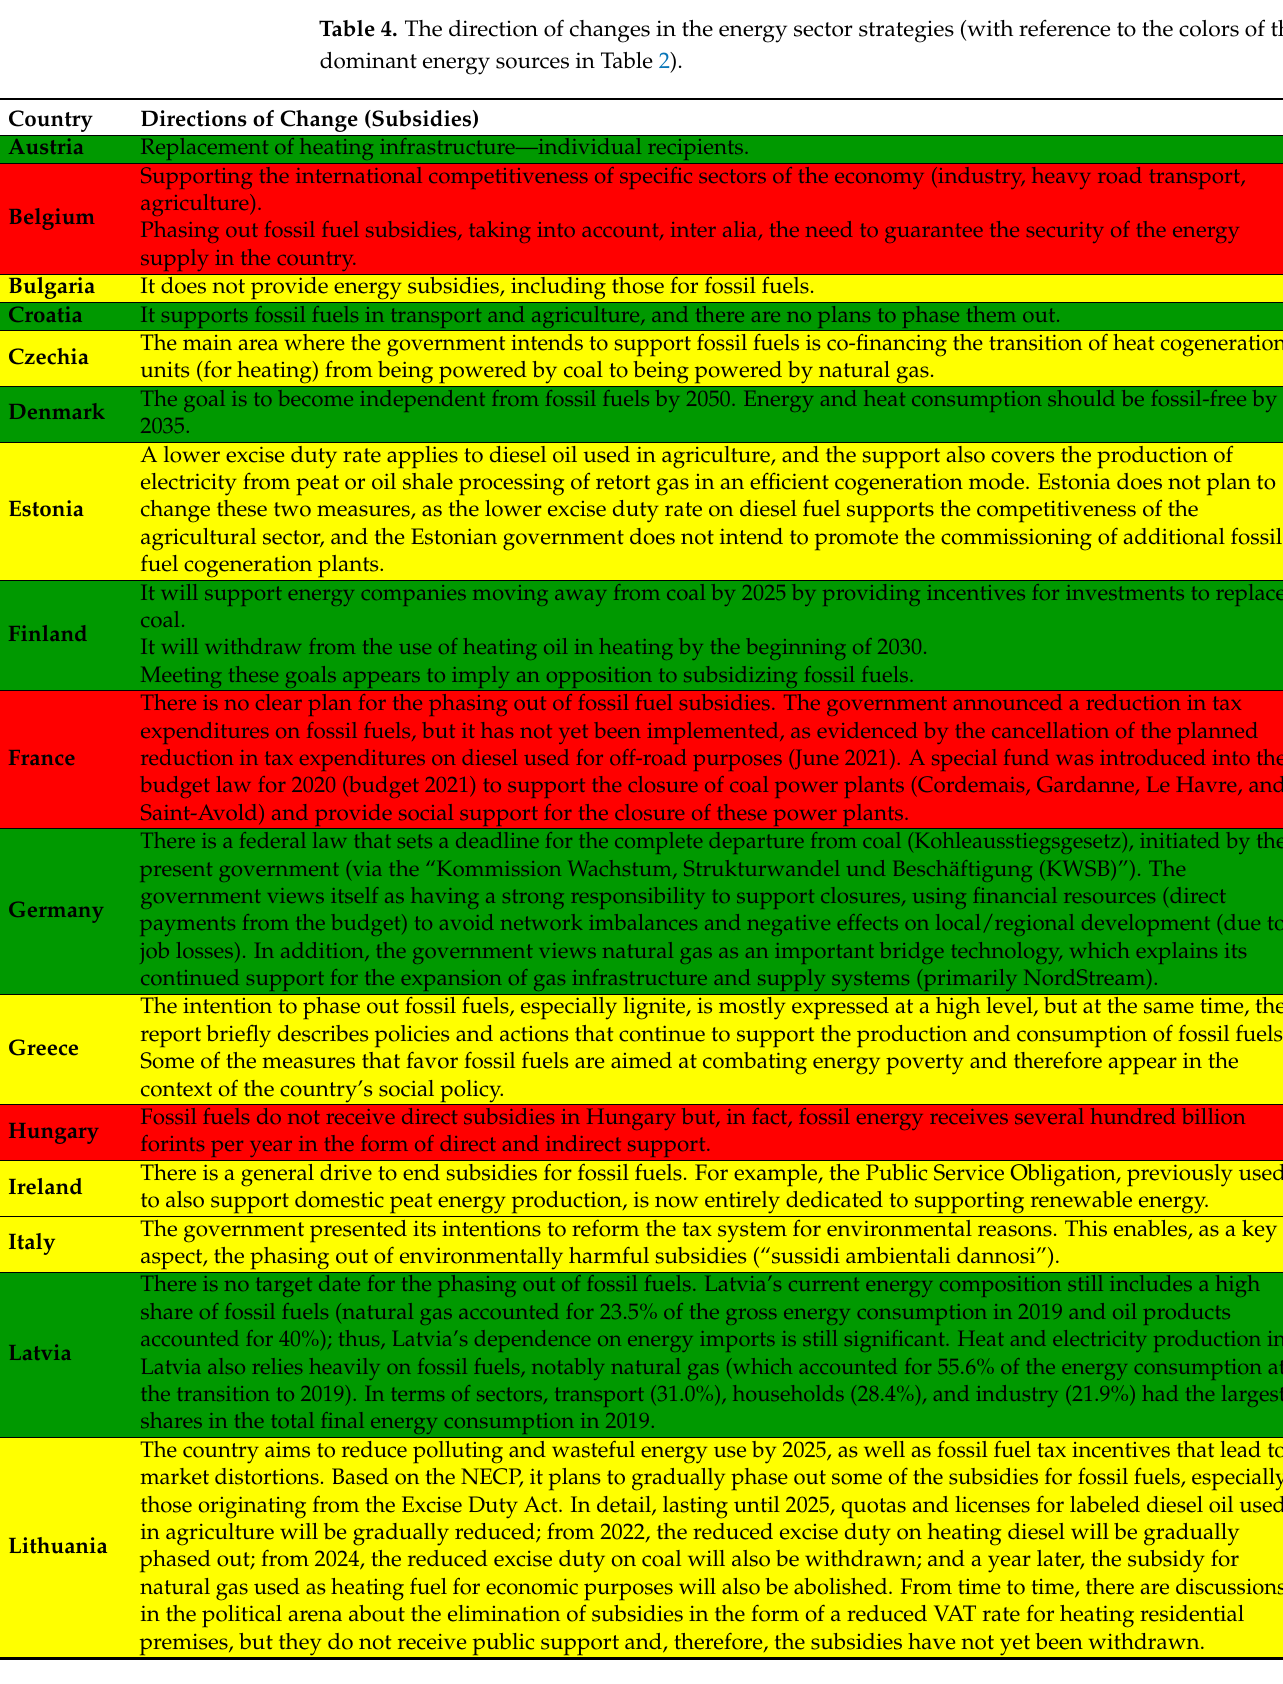
Table 4. The direction of changes in the energy sector strategies (with reference to the colors of the dominant energy sources in Table